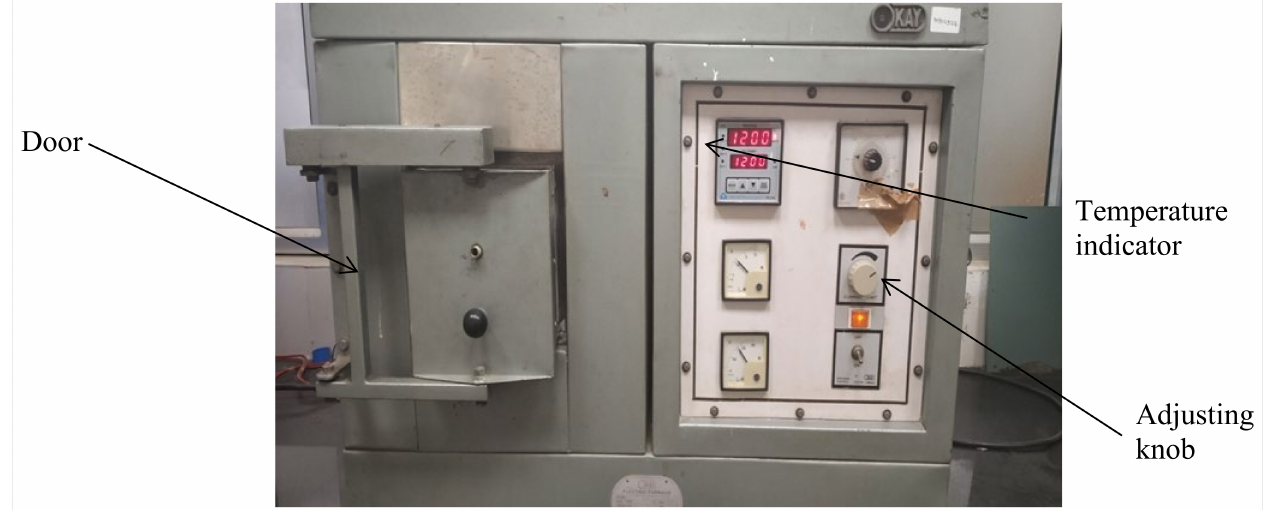
Figure 6. Electrical resistance based conventional heating setup.